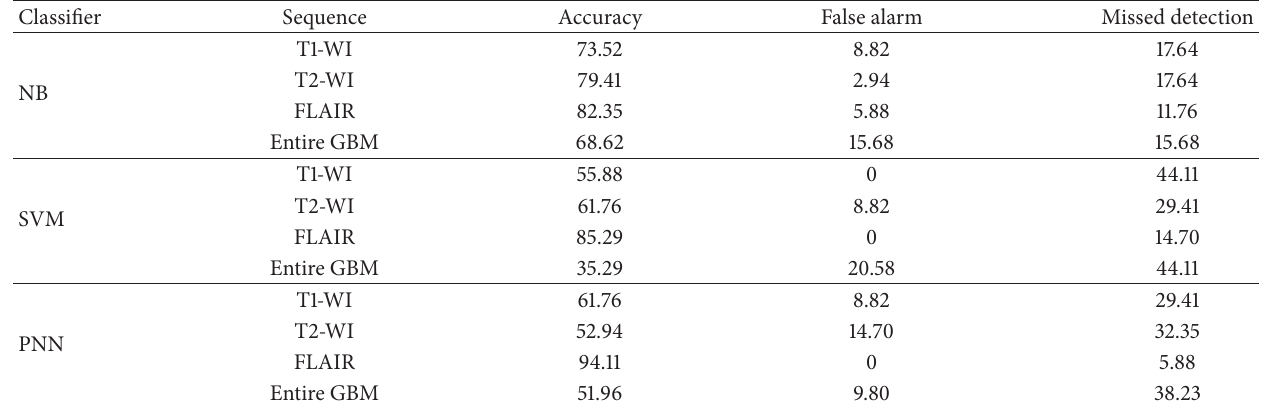
Table 2: Performance metrics (%) based on the PCA features.